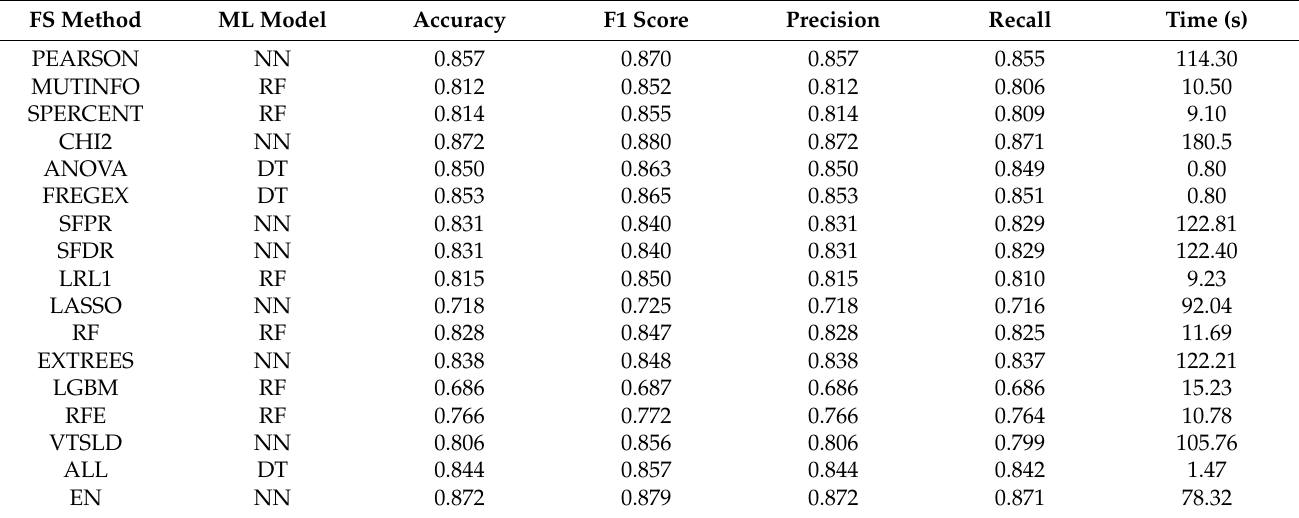
Table 7. Individual FS method best performance summary in machine learning.